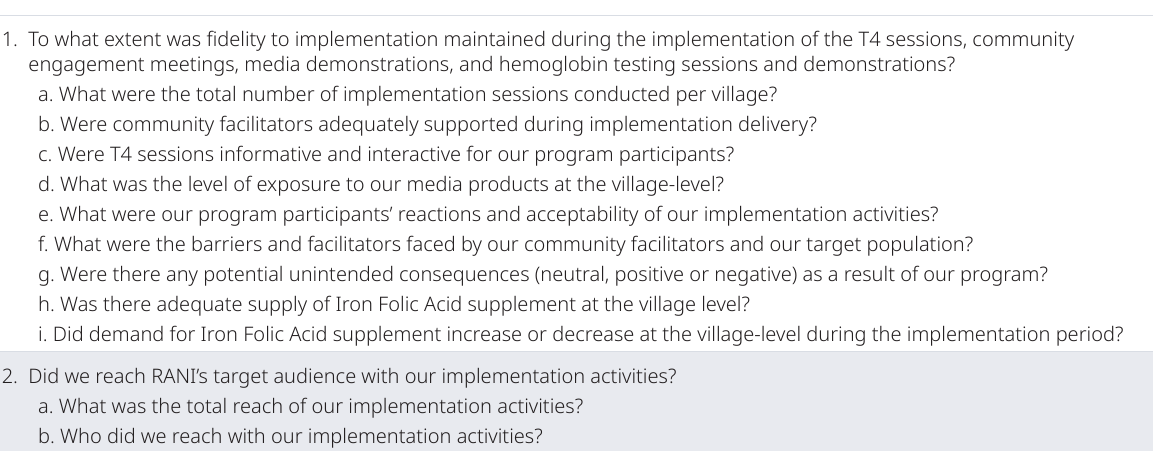
Table 1. Process evaluation